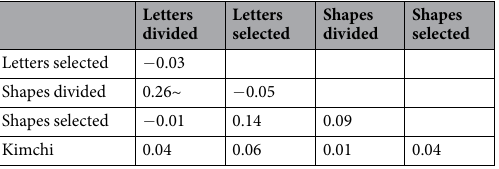
Table 1. Correlations between the global advantage effects in the 4 conditions of the Navon task and the Kimchi-Palmer